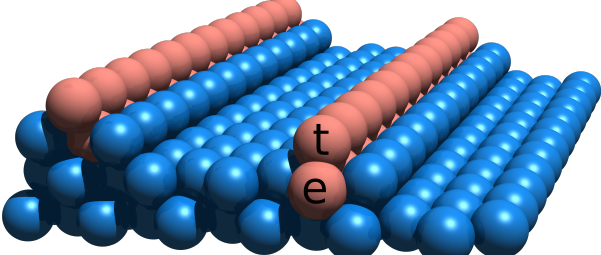
Figure 1. A one-atom-wide Fe double chain (brown) is formed on a vicinal Cu(111) surface (blue). Fe chains at the top (t) and embedded (e) positions are also